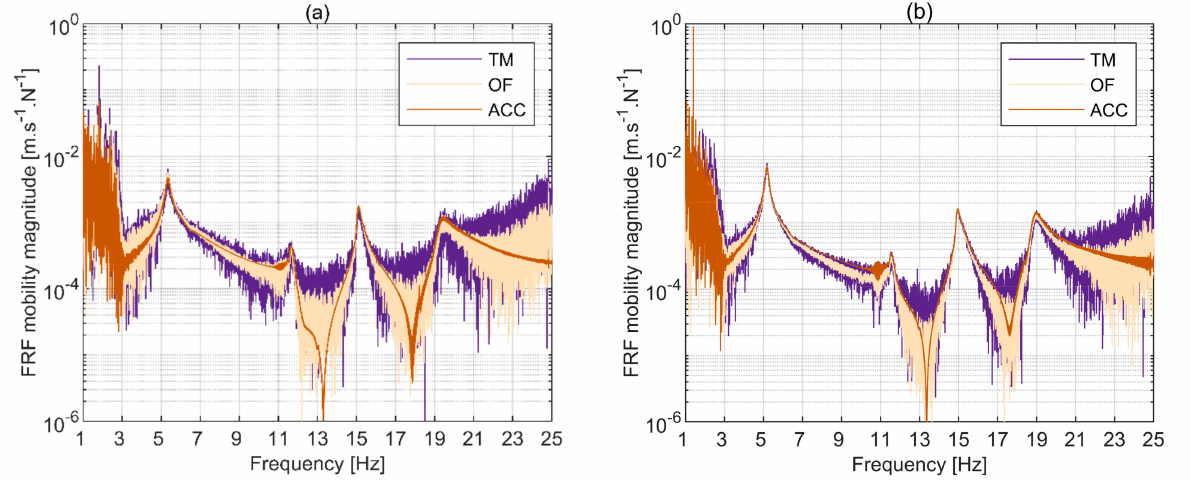
Figure 9. Driving point FRF mobility from sine chirp excitation in ( a ) T3 and ( b )